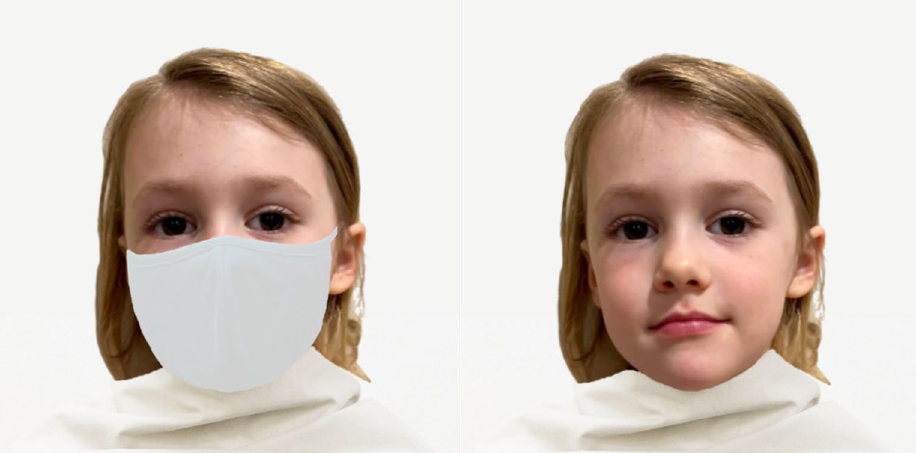
Figure 1. Example of face stimuli used in Experiments 1–4. Participants were randomly assigned to view faces that were masked (left) or unmasked